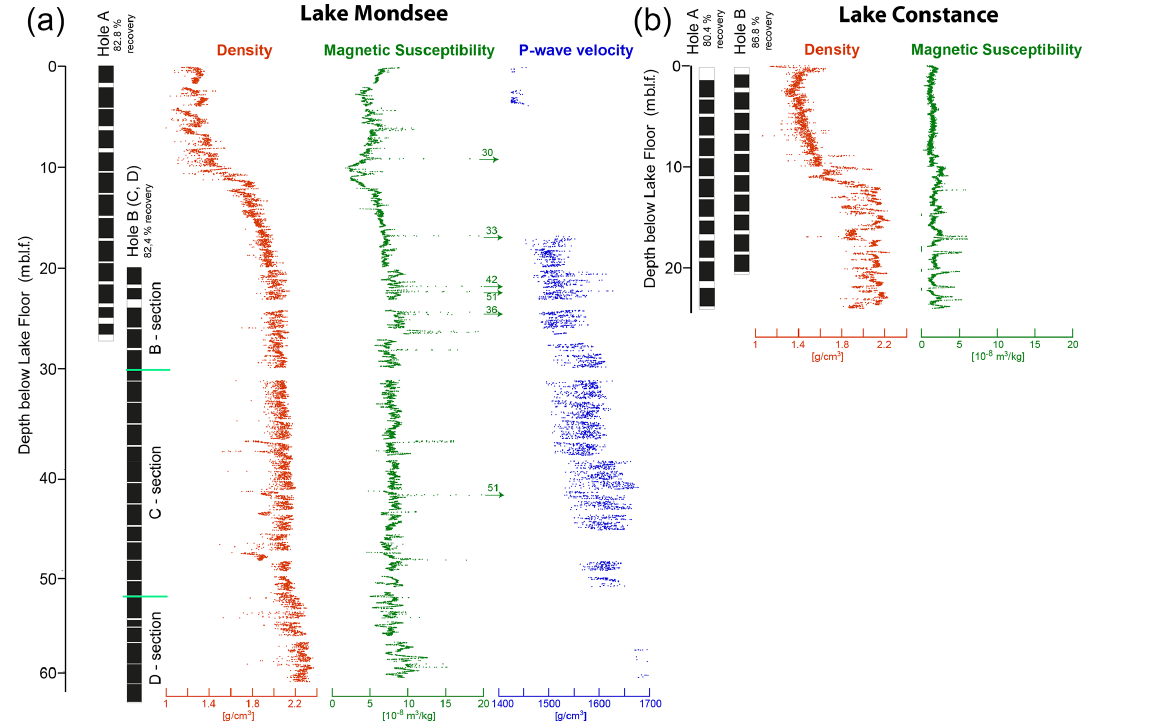
Figure 7. Core recovery (a) and physical property data by multisensor core logger (MSCL) (b) data for the composite cores from lakes Mondsee (above) and Constance